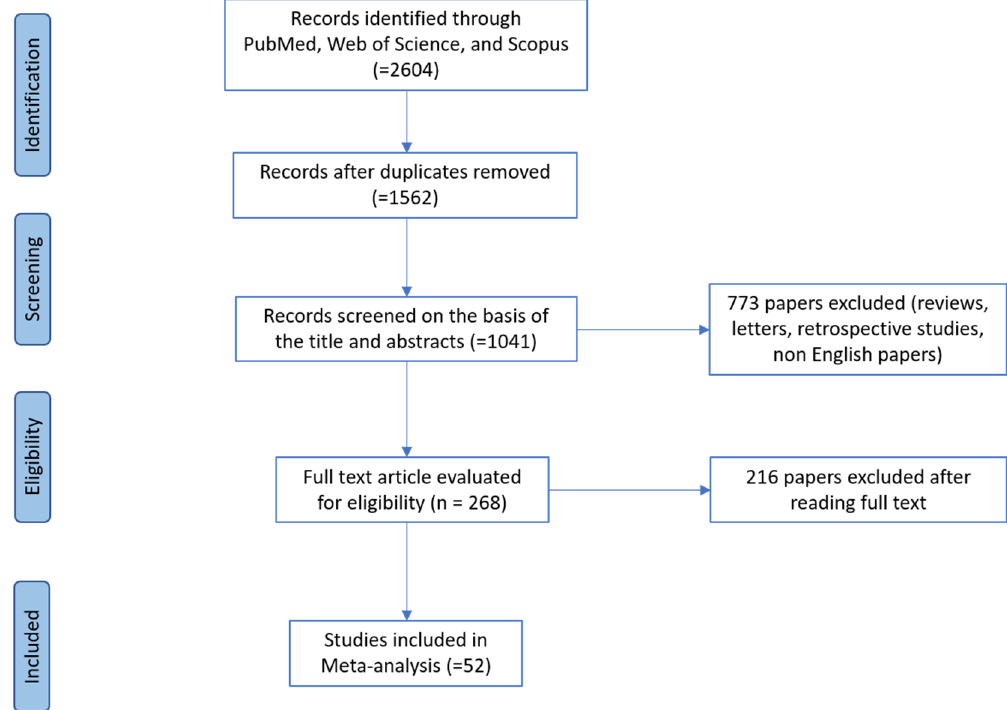
Figure 1. PRISMA (Preferred Reporting Items for Systematic reviews and Meta-Analyses) flow diagram.